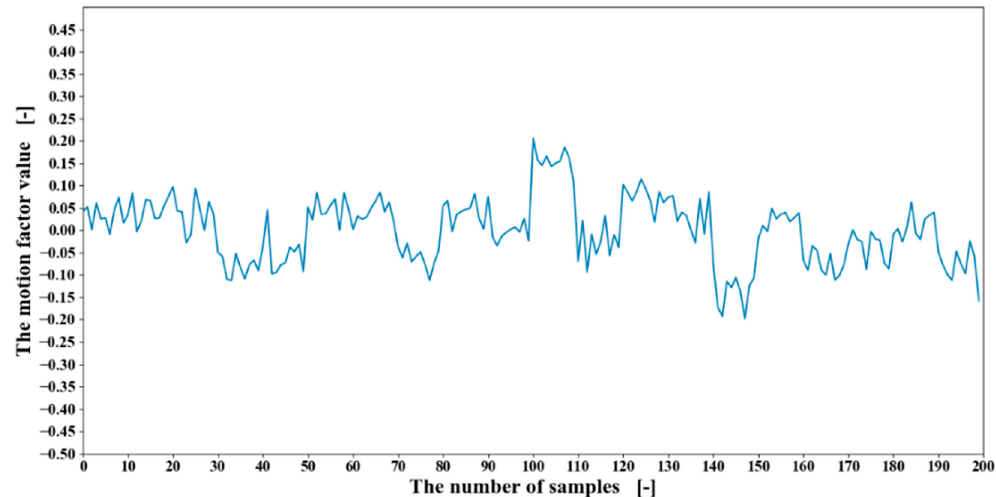
Figure 13. The extracted motion matrix factor values of participant one by the bilinear model. Table 7. The classification accuracy of 20 participants with the bilinear model. Predicted Label